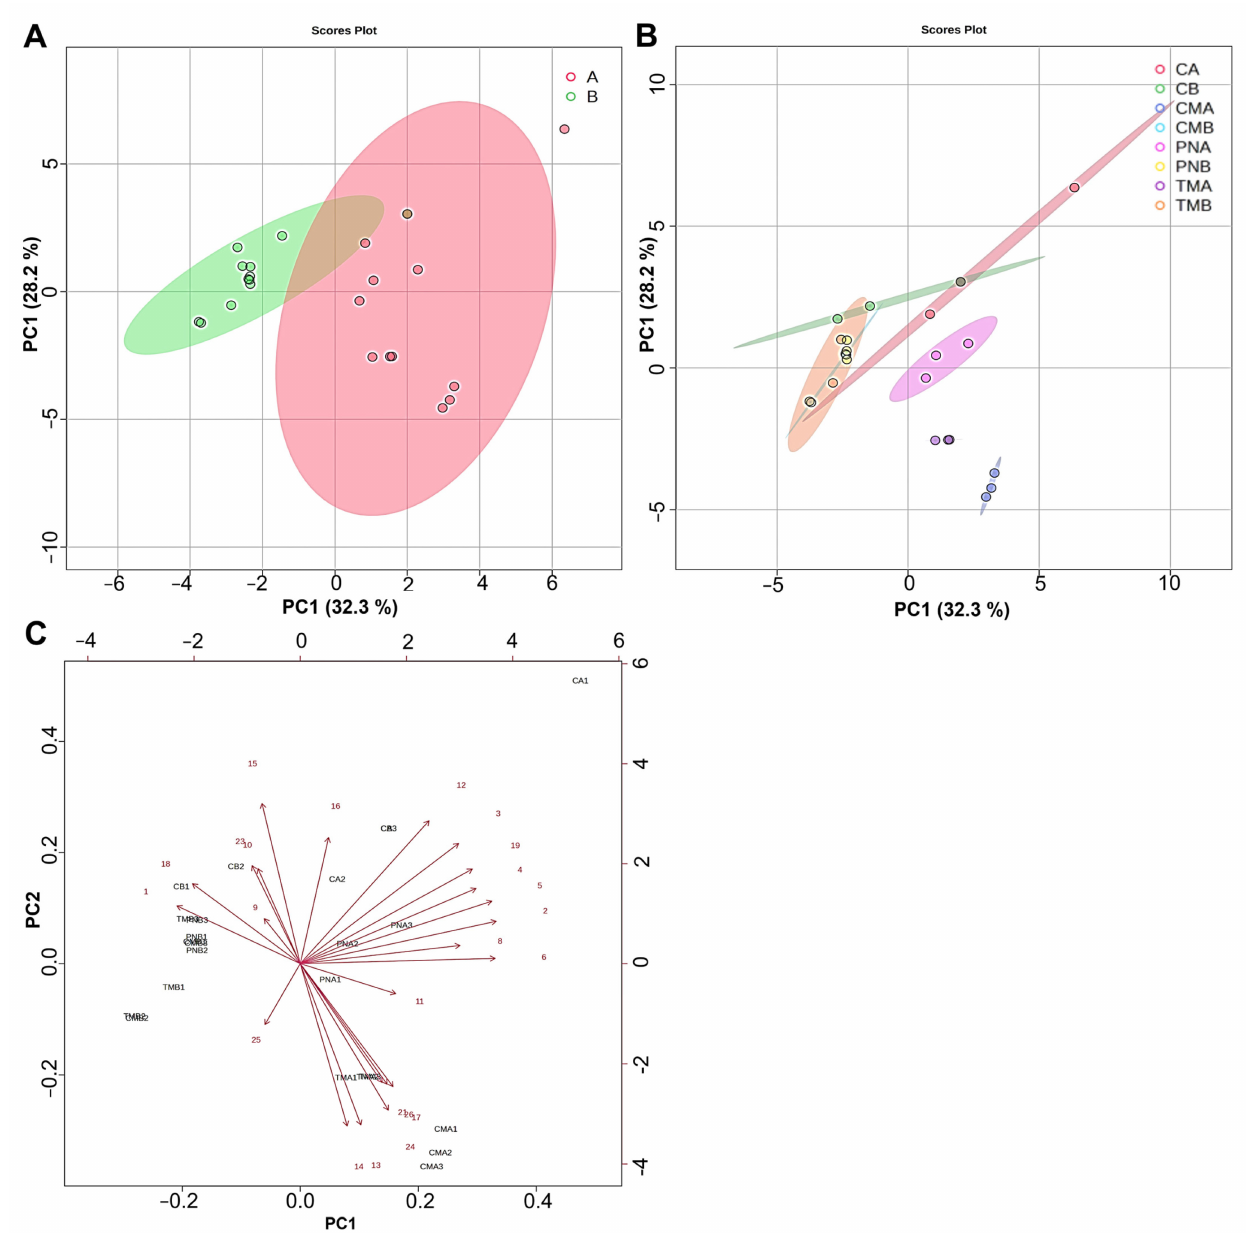
Figure 2. Principal component analysis of volatile organic compounds: ( A ) Score plot of ciders produced with different T. delbrueckii strains; ( B ) score plot of ciders obtained with different methods; ( C ) biplot based on VOC composition of samples. C: base cider; PN: P é t-Nat; TM: Champenoise method, CM: Charmat method. A and B indicate ciders fermented by T. delbrueckii strain A and strain B, respectively. (1) Acetic acid ethylester; (2) i-butanol; (3) propionic acid ethylester; (4) 3-methyl- butanol; (5) 2-methyl-butanol; (6) i-butyric acid ethylester; (7) 2-methylbutyric acid methylester; (8) butyric acid ethylester; (9) lactic acid ethylester; (10) i-valeric acid; (11) 2-methylbutyric acid ethylester; (12) hexanol; (13) acetic acid 3-methylbutylester; (14) acetic acid 2-methylbutylester; (15) hexanoic acid; (16) hexanoic acid ethylester; (17) acetic acid hexylester; (18) 2-hydroxy-4- methylvaleric acid ethylester; (19) 2-phenyl-ethanol; (20) octanoic acid; (21) succinic acid diethylester; (22) octanoic acid ethylester; (23) benzeneacetic acid ethylester; (24) acetic acid phenylethylester; (25) decanoic acid; and (26) decanoic acid